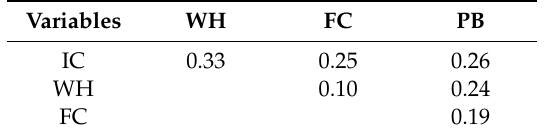
Table 5. Intercorrelations Social Distance Scale (v1) subscale scores.